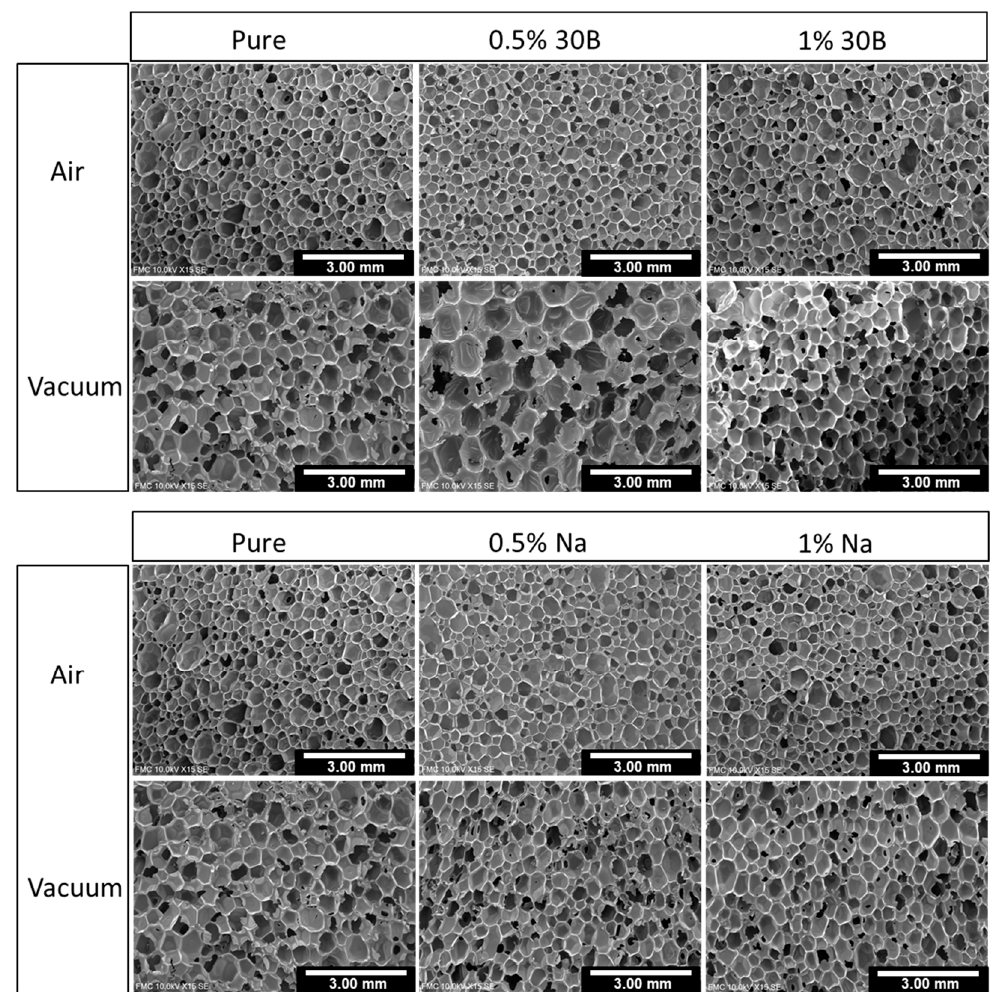
Figure 2. SEM micrographs of the polyurethane foams.